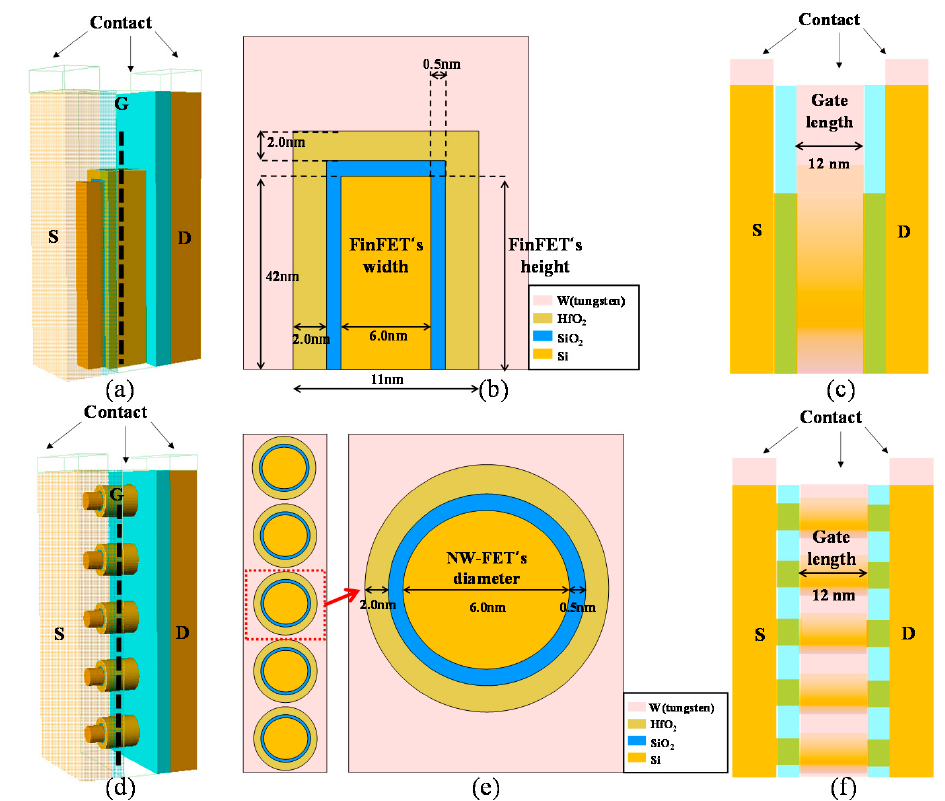
Figure 1. Technology computer-aided design (TCAD) structures of the FinFET and Nanowire FET (NW-FET). ( a ) FinFET 3D structure; ( b ) FinFET’s cross-section of gate; ( c ) FinFET’s cross-section of channel length; ( d ) NW-FET 3D structure; ( e ) NW-FET’s cross-section of gate; ( f ) NW-FET’s cross-section of channel